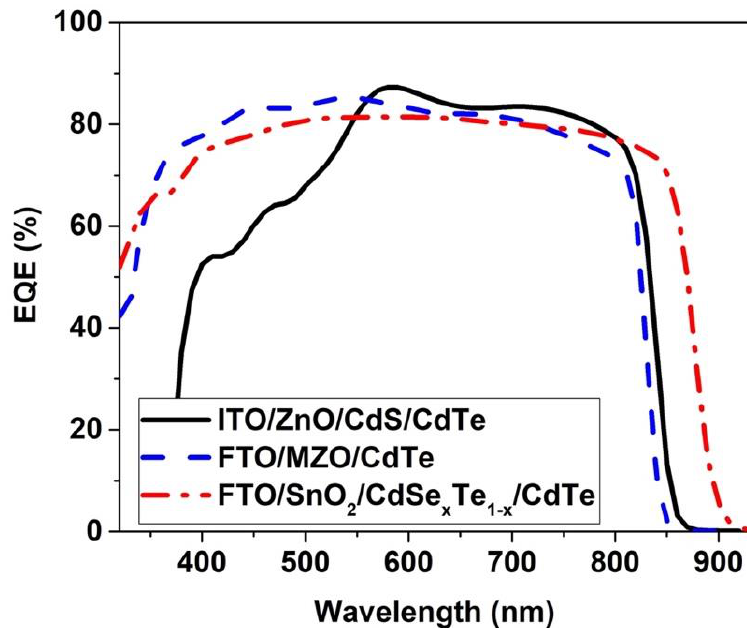
Figure 14. External quantum efficiency of CdTe devices made with different buffer layers.